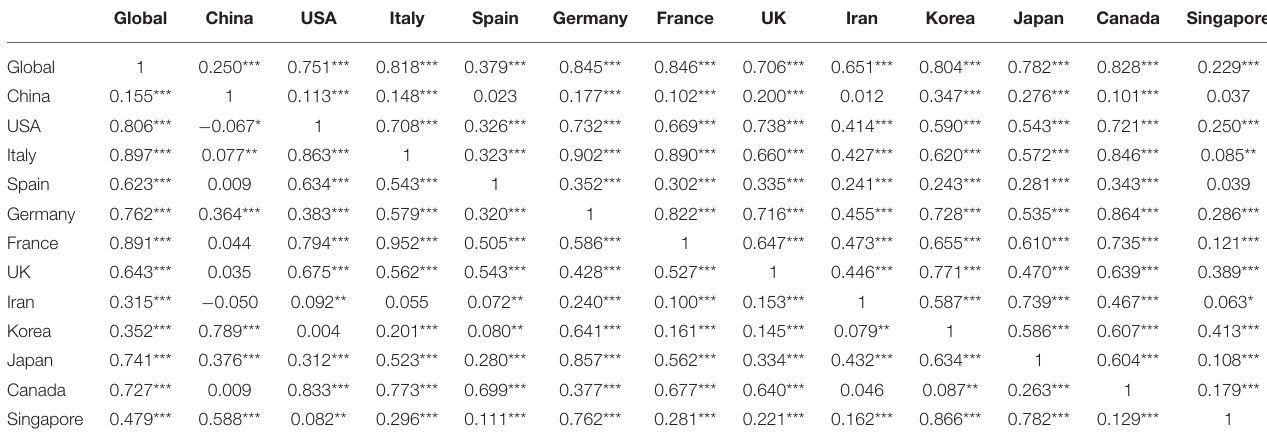
TABLE 1 | Correlation